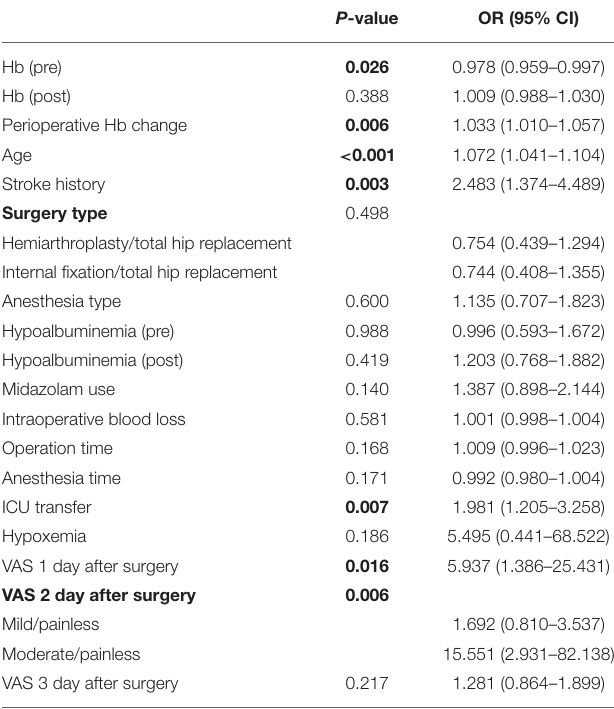
TABLE 3 | The logistic analysis of POD.